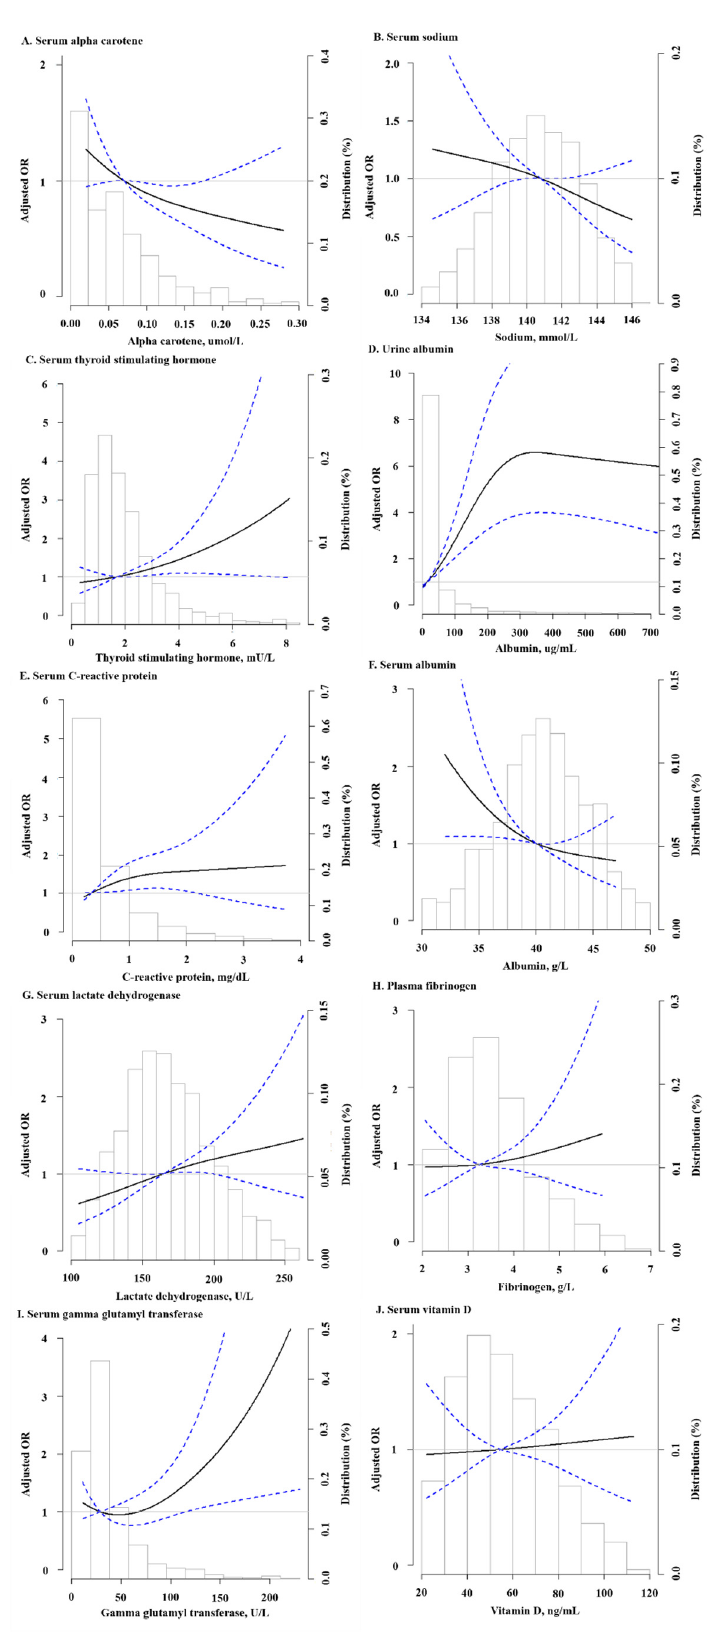
Figure 1. The associations of biomarkers and odds ratio of all-cause mortality using adjusted restricted cubic spline models (95% confidence intervals). ( A – J ) showed alpha carotene, serum sodium,